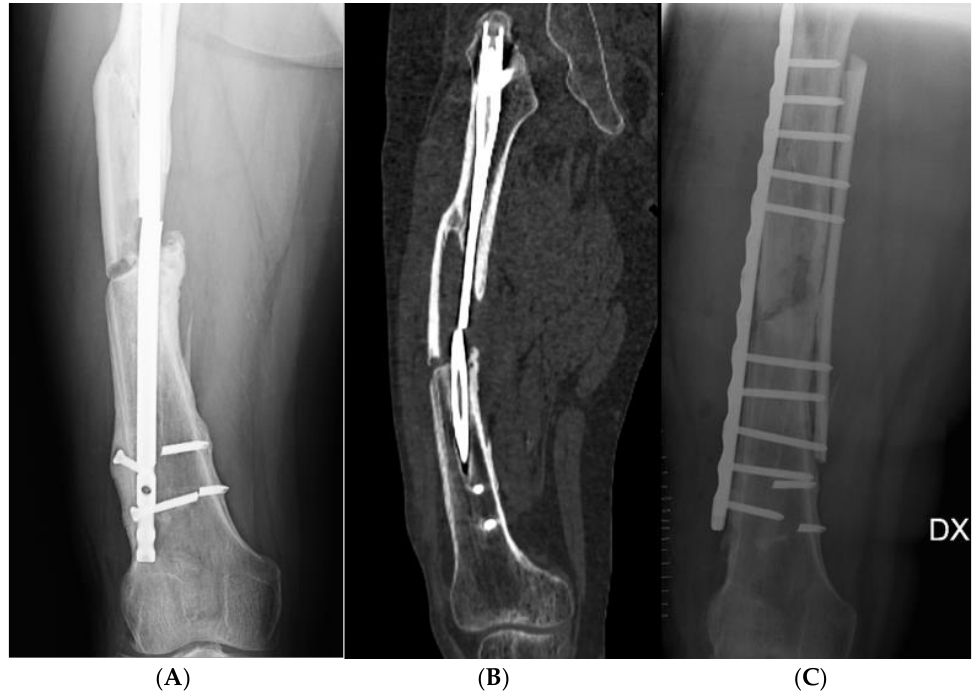
Figure 1. 46-year-old patient with a closed 32-B2 fracture. ( A ) Anteroposterior X-ray showing PSA at the middle third of femoral diaphysis, initially treated with an intramedullary nail, which appear broken at the fracture site. ( B ) Coronal CT section of the femur showing the PSA focus, the broken nail and posterior bone loss. ( C ) Anteroposterior X-ray of the femur after revision surgery with lateral plate and screws and medial bone graft splint.